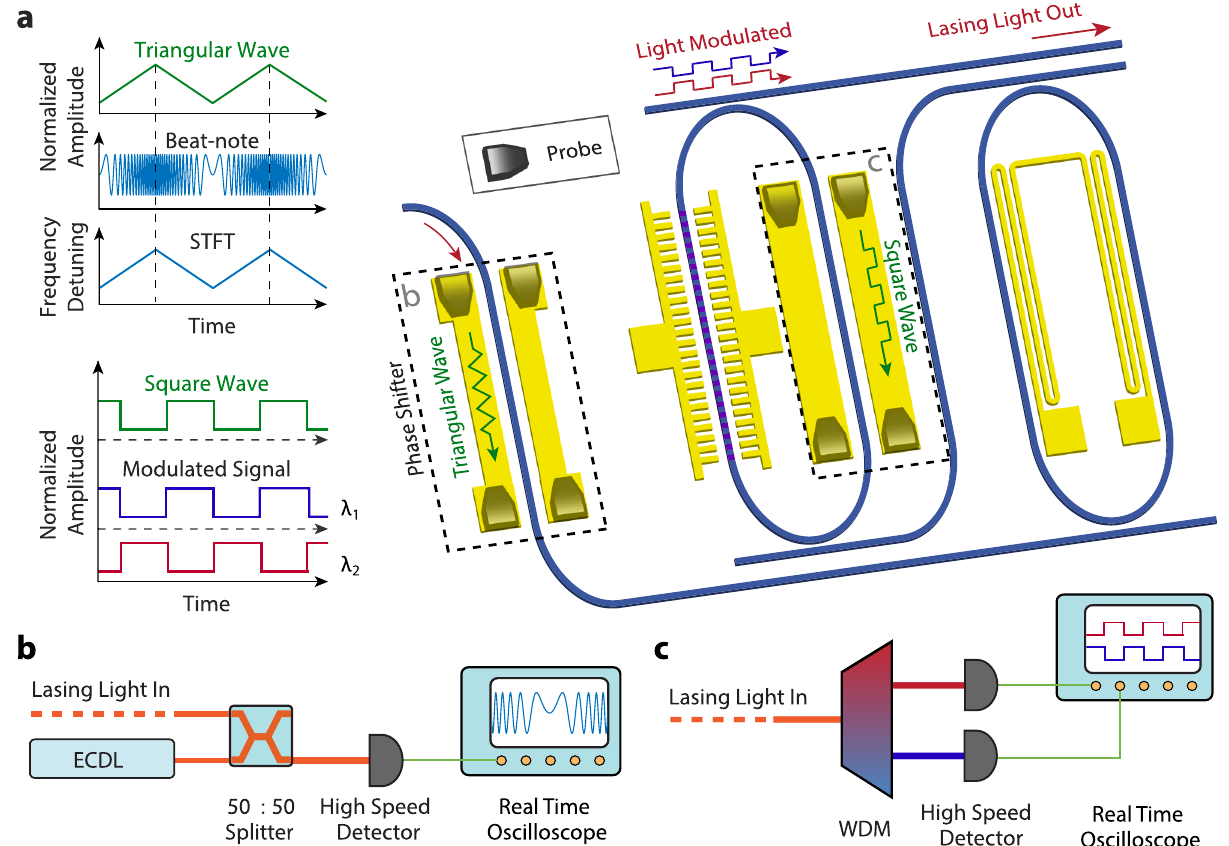
Fig. 7 | Experimental setup for high-speed tuning and switching of the laser. a Right: Schematic of device with probes placed for high-speed characterization. Dashedlinesare usedto highlight the operating units. UpLeft: Schematicofsignal waveformsforlaserfrequencymodulation.Top:triangularelectricalsignaltodrive the phase shifter; middle: laser beat note; bottom: time-frequency spectrogram retrieved by the STFT. Down Left: Schematic of signal waveforms for laser-mode